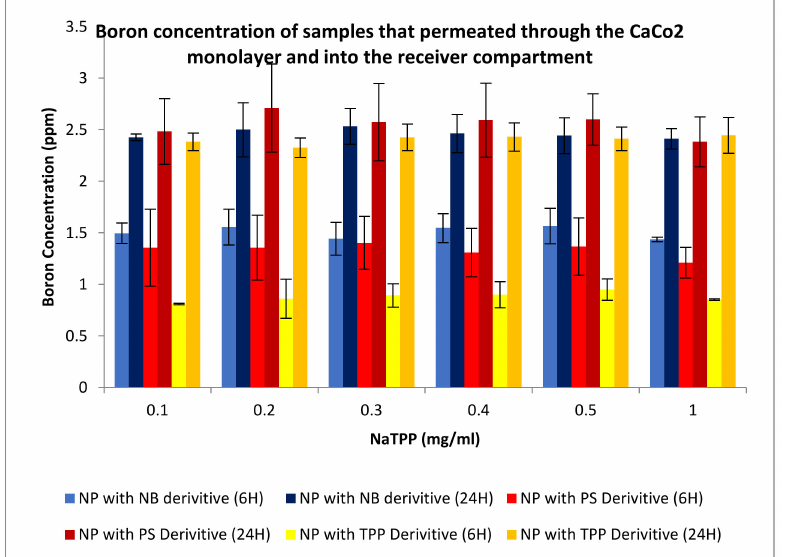
Figure 20. Boron concentrations of the compound that has permeated through a cellular monolayer from nanoparticles (NP) formulated through ionotropic gelation. Boron concentrations for permeated boron were undertaken for compound 2 (TPP), compound 4 (NB), and compound 6 (PS).